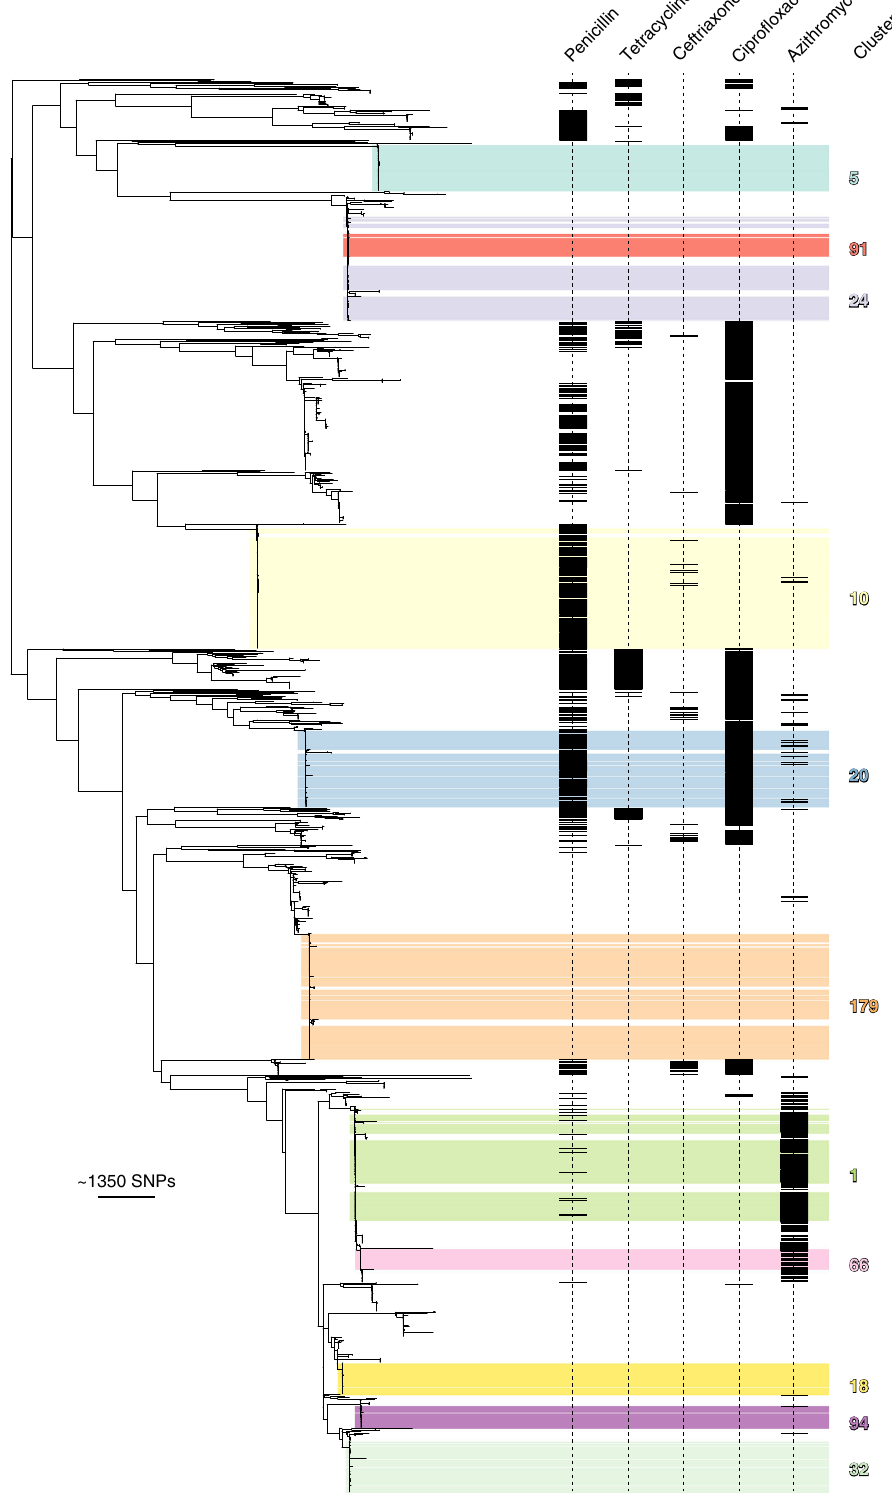
Fig. 2 Population structure of 2186 N. gonorrhoeae isolates included in this study. The mid-point rooted maximum-likelihood tree (derived from 45,145 core SNPs) is plotted on the left. Phenotypic resistance (or decreased susceptibility for ceftriaxone) pro fi les are shown on the right, and major clusters are highlighted in colour. The scale bar represents the single nucleotide polymorphism (SNP)